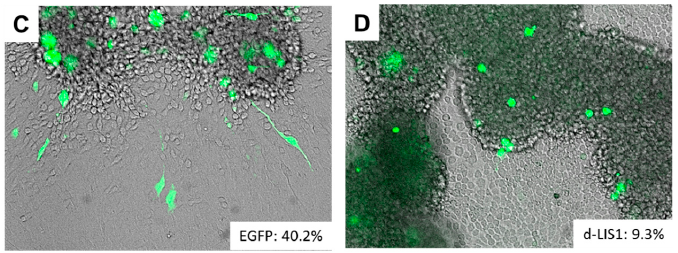
Figure 1. Neuro-developmental gene products in infiltrating glioma cells. ( A , B ) Microtubule-associated proteins, which are important in migration of glial (( A ) MAP-2e) and neural (( B ) DCX) progenitor cells clearly delineate infiltrating glioma cells, well demonstrating the leading processes. Images reproduced from [7]. Scale bar = 15 µm; ( C , D ) GFP-labeled C6 rat glioma cell lines vigorously migrate out of the sphere (( C ) 40.2%) whereas overexpression of dominant negative form of neuro-developmental gene LIS1 (d-LIS1) significantly reduced the ratio of migration (( D ) 9.3%), suggesting its role in glioma cell invasion. MAP-2e, microtubule-associated protein-2e; DCX, doublecortin; EGFP, enhanced green fluorescent protein; d-LIS1, dominant negative form of lissencephaly-1.